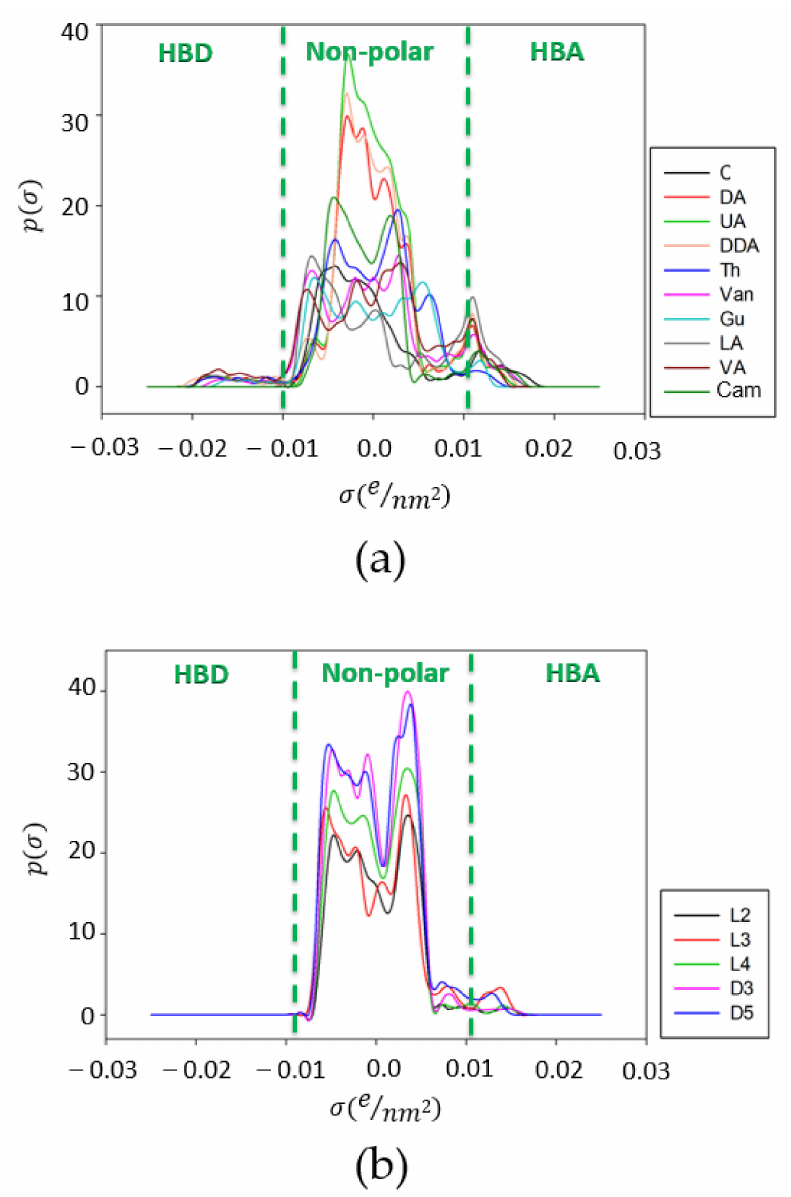
Figure 3. σ -profiles of ( a ) DES components and ( b ) siloxanes. To confirm the results obtained using the σ -profiles, electrostatic potential (ESP) analysis was performed for DES components and selected siloxanes. The electrostatic potential of DESs and siloxanes are mapped onto electron densities in Figures 4 and 5. The positive potential regions are depicted as blue, red indicates negative potential, and white represents the potentials that are close to zero. The obtained results indicated that the electropositive area in DES component structures was located around the hydrogen atoms in the –C-H and –O-H groups. The electronegative area was located around the oxygen atom in the –O– and =O groups, and the neutral region was located around carbon atoms. During the formation of DESs, the electropositive area from one of the DES components (HBD) attracted the electronegative region of the second component (HBA). In this way, strong hydrogen bonds were formed between the DES compounds, resulting in the formation of stable DES. Figure 5 shows that, in all siloxane compounds, only a neutral region could be identified. This indicated that other weaker non-bonded interactions must play the dominant role in the capture of siloxane by